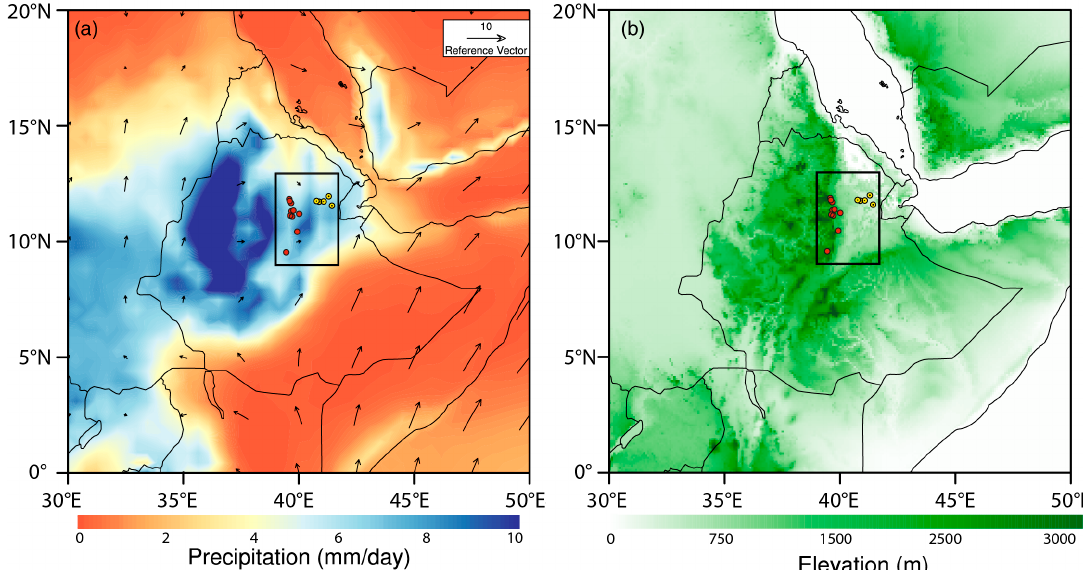
Figure 1. ( a ) Mean summer monsoon precipitation (Kiremt) and anomalous vector wind at 850 hPa, based on HadGEM3 downscaled ERA-Interim (mm / day) data for 1990–2008 and on Global Precipitation Climatology Center (GPCC) data, respectively. ( b ) Topographic map of Ethiopia (elevation data interpolated from GTOPO30). Yellow and red circles in ( a ) and ( b ) show the locations of the rainfall stations in Afar and Amhara, respectively. Black arrows in ( a ) indicate the atmospheric surface circulation pattern during the Kiremt monsoon season. Reference arrow given in m s − 1 . Table 1. Details of the 15 rainfall stations used in the study. Note that two other stations (Awara Melka and Awash 7 kilo) were excluded from the analysis because of concerns with data integrity (see text).